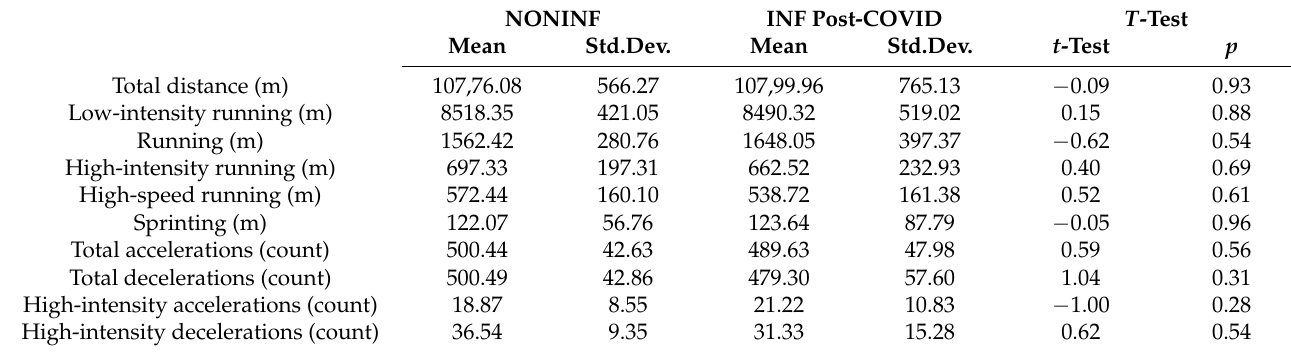
Table 3. Descriptive statistics for match running performances and independent sample T -test differences between non-infected players (NONINF) and infected players after return to play after COVID-19 (INF post-COVID).